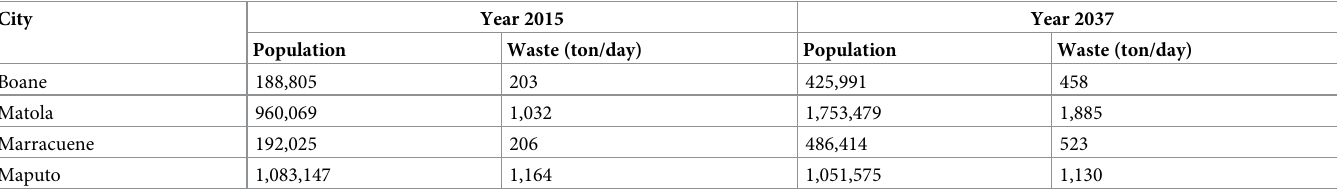
Table 3. Current and future projected waste generation in the greater Maputo area, by